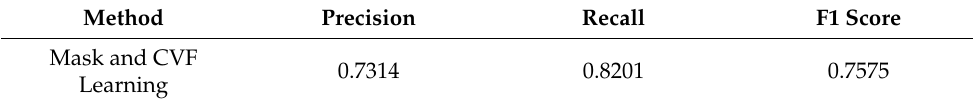
Figure 7. Road Extraction Results Using Mask and CVF Learning. Table 2. The performance evaluation of road extraction using mask learning and CVF.